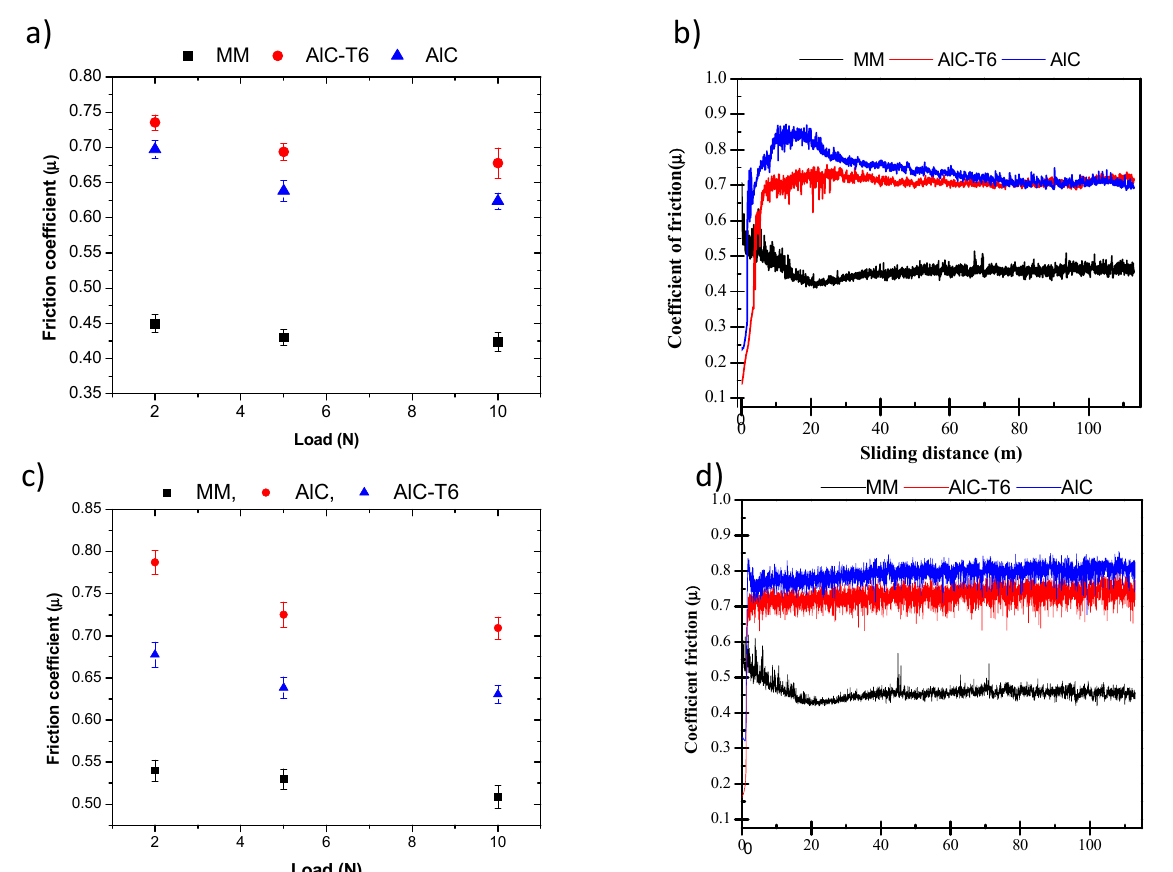
Figure 5. Mean friction coefficients of Al-MM, AlC, and AlC-T6 at three loading conditions and dynamic friction coefficients at 5 N: in the tribological pairs with ( a , b ) 52100 steel and ( c , d ) α -Al 2 O 3 , respectively.